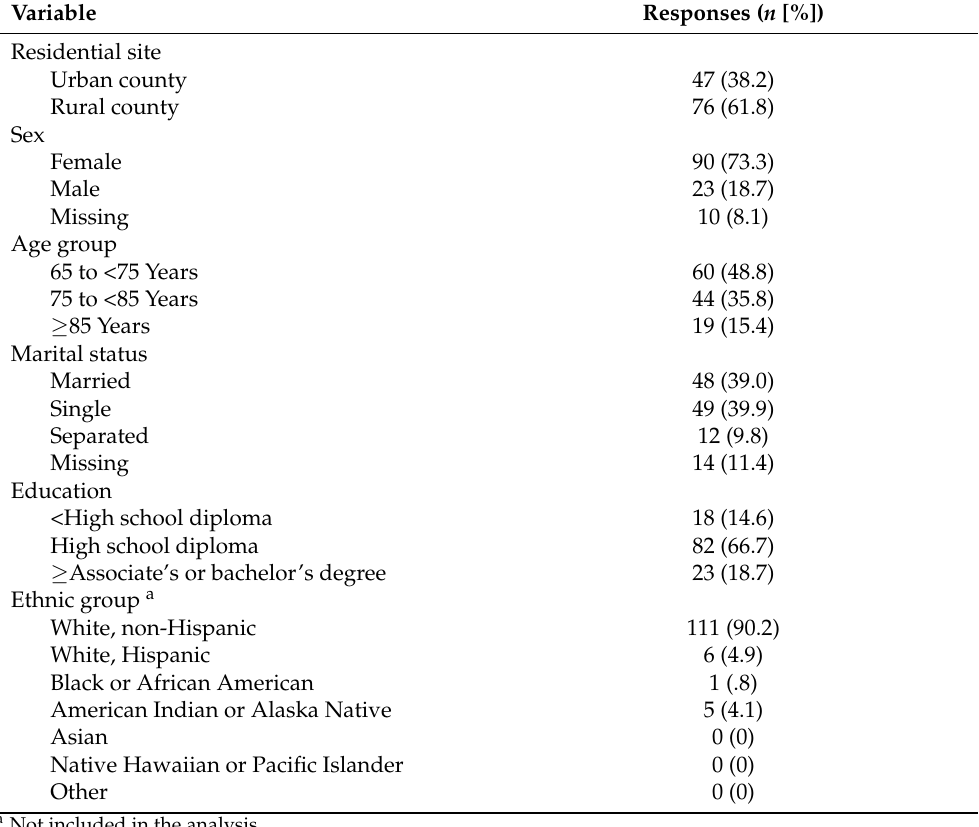
Table 1. Demographics of the 123 older community-dwelling adult participants.